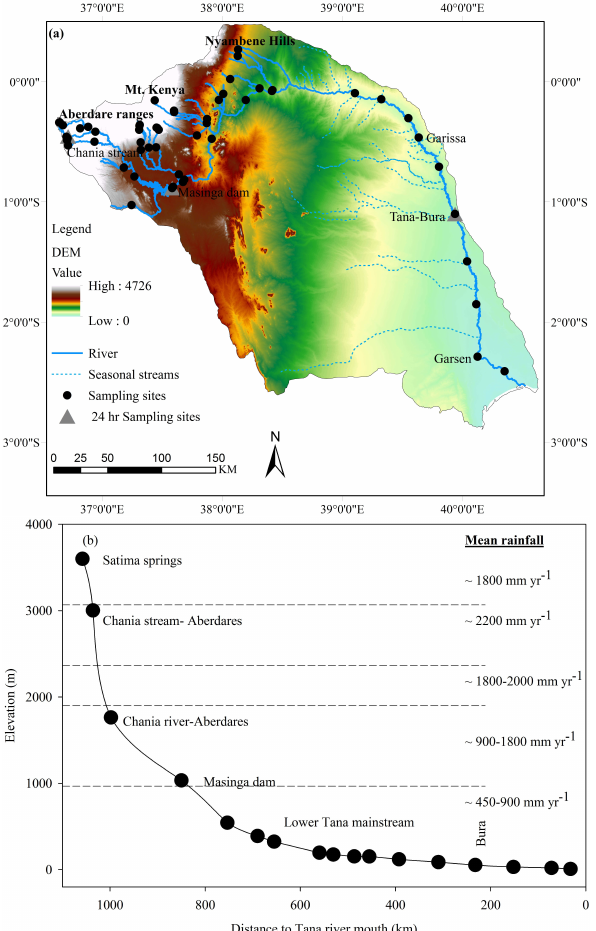
Fig. 2. (a) Digital elevation model (DEM) of the Tana River basin, which consists of two main geographical units – the Tana head- waters and the lower Tana mainstream. The 57 sampling sites are indicated by black dots. (b) Profile of the Tana River from headwa- ters to Tana mouth. Sampling stations for the lower Tana River are indicated, as well as a selected number of headwater sampling sites to show their overall position. Note: Chania Stream, Masinga Dam (close to intake) and Tana-Bura are 24h cycle sampling sites.